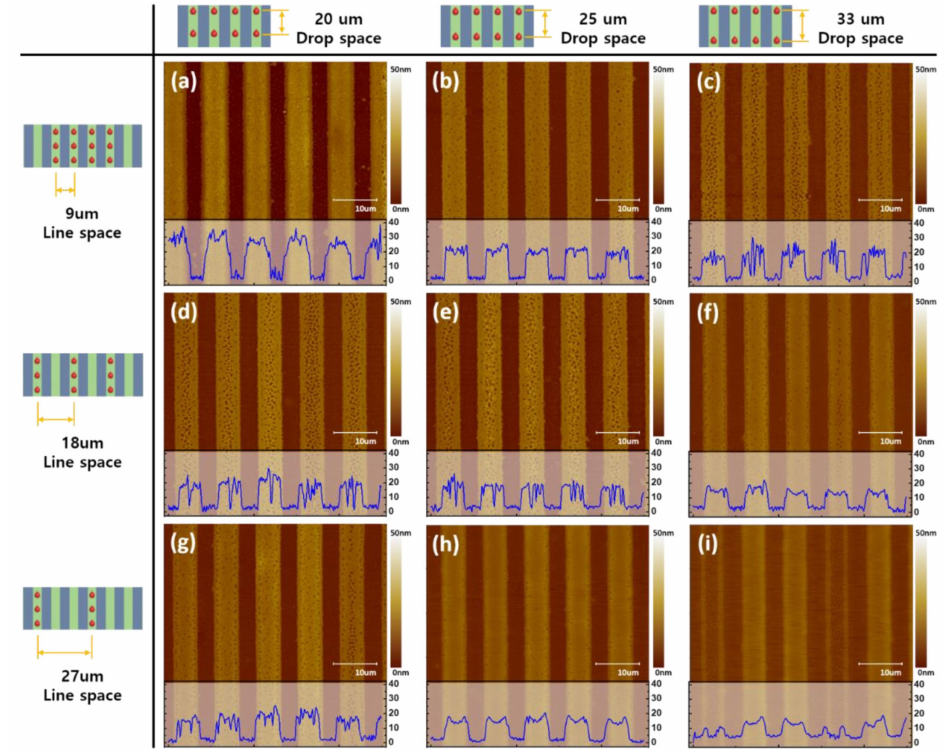
Figure 4. AFM images of sublimation transferred patterns according to the drop and line space. Inkjet-printed with ( a – c ) 9 µ m, ( d – f ) 18 µ m, and ( g – i ) 27 µ m for line space, and ( a , d , g ) 20 µ m, ( b , e , h ) 25 µ m, ( c , f , i ) and 33 µ m for drop space. Insets are cross-sectional data,